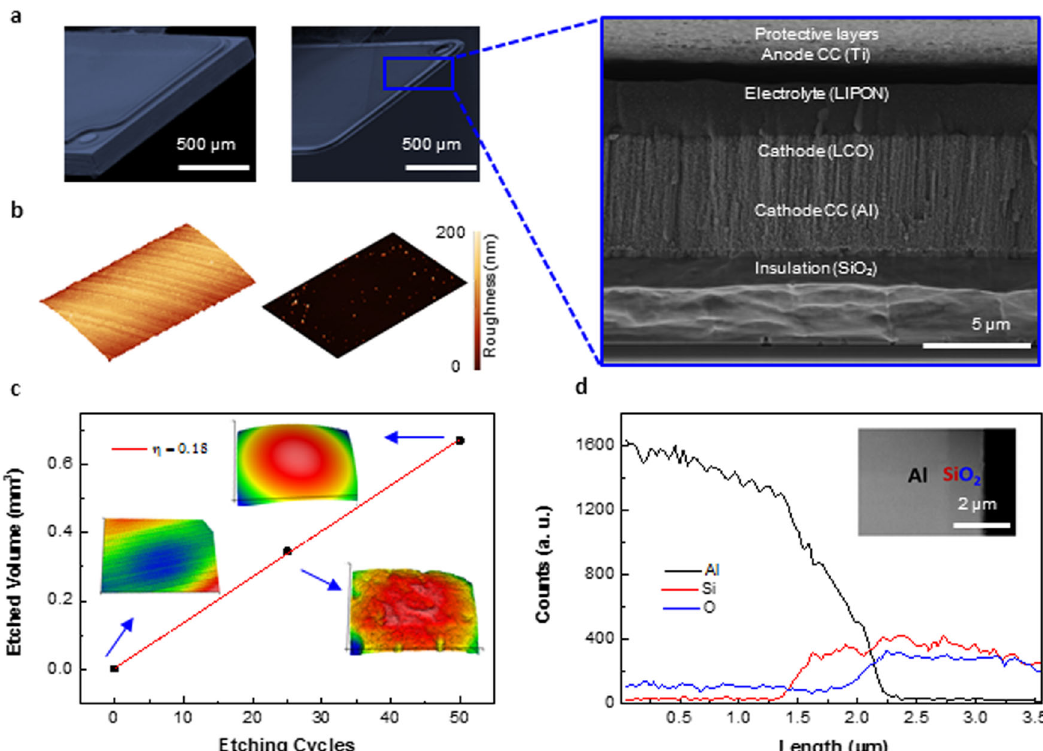
Fig. 2 Flexing process for a bio-compatible fl exible lithium-ion battery. a SEM images of a bulk thin- fi lm Si-supported battery (left panel; 130 μ m total thickness) compared to thinned fl exible battery with complete removal of Si support (middle panel; 30 μ m total thickness). Cross section SEM image of the fl exible thinned battery components made from all solid-state materials (right panel; lithium-free anode battery con fi guration). b Progressive Si back surface evolution of the battery undergoing selective dry etching as observed in a 15 × 10 μ m 2 AFM mapped region of the battery ’ s backside at zero etching cycles (left panel; roughness from wafer grinding), and with completed etching at 50 cycles (right side panel; fl at surface and complete Si consumption). c Etching ef fi ciency calculation through determination of the total etched volume using optical pro fi ler measured across different etching cycles. d Con fi rmation of Si removal from the battery ’ s backside using elemental linear scan EDS analysis with the corresponding HAADF-STEM image ( inset image